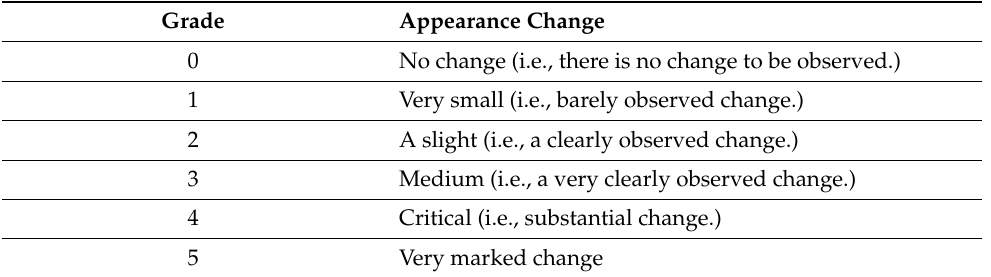
Table 4. Displaying grade of appearance